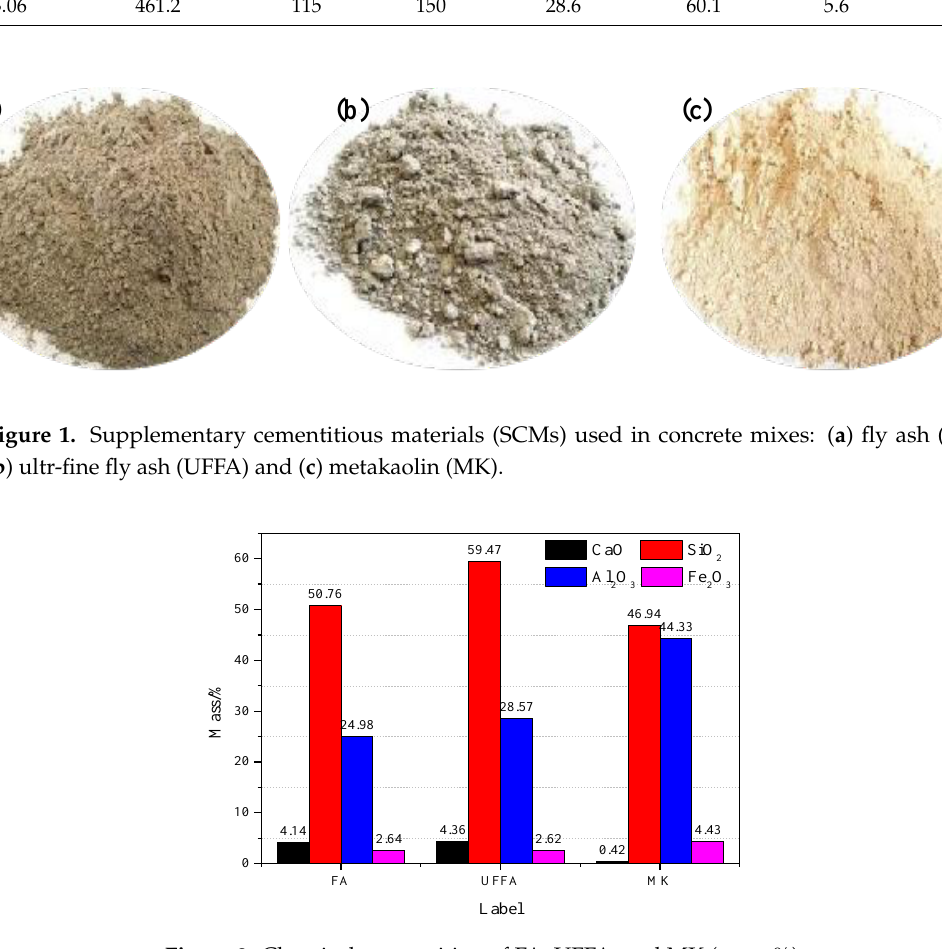
Figure 2. Chemical composition of FA, UFFA, and MK (mass %). Table 2. The grain size distribution of aggregates.